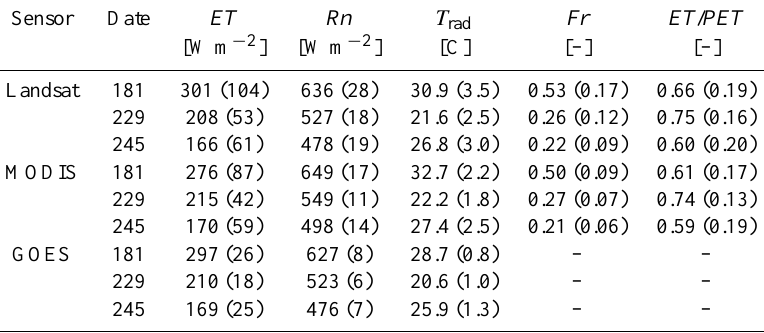
Table 1. Spatial mean and standard deviation in parentheses for evapotranspiration ( ET , [Wm − 2 ]), net radiation ( Rn , [Wm − 2 ]), surface temperature ( T rad , [C]), fractional vegetation ( Fr , [–]), and water limitation ( ET / PET , [–]) for each sensor (Landsat, MODIS, and GOES) for each day of consideration (181, 229, and 245).